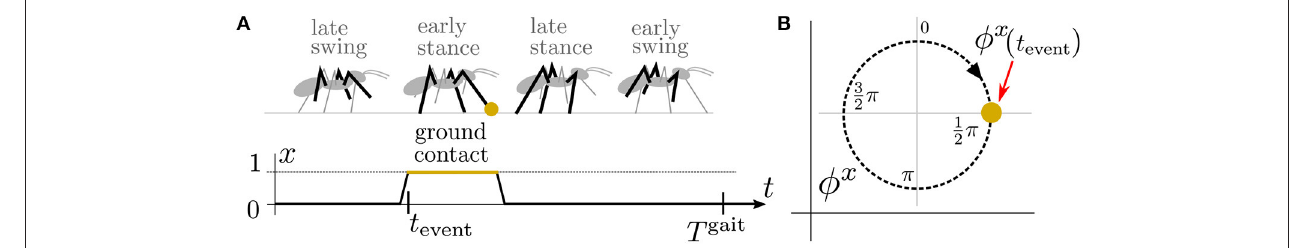
FIGURE 2 | (A) An illustration of an ant during the tripod gait, a motion pattern where three legs propel the body while the other three legs swing forward. During the T gait . During the tripod gait, the ant puts a front leg on the ground and senses the ground contact with x ( t event ) = 1 at the fourth of the gait period t event = 1 4 regular motion, such an event occurs periodically with x ( t event + nT gait ) = 1 for any n ∈ N . Therefore, (B) for the sensory signal x , we define the sensory phase φ x π for any n ∈ N . Notice that the sensory phase is directly measured only at t event , and there on which we can map the event occurrence at φ x ( t event + nT gait ) = 1 2 is no sensory phase measurement for the rest of the gait